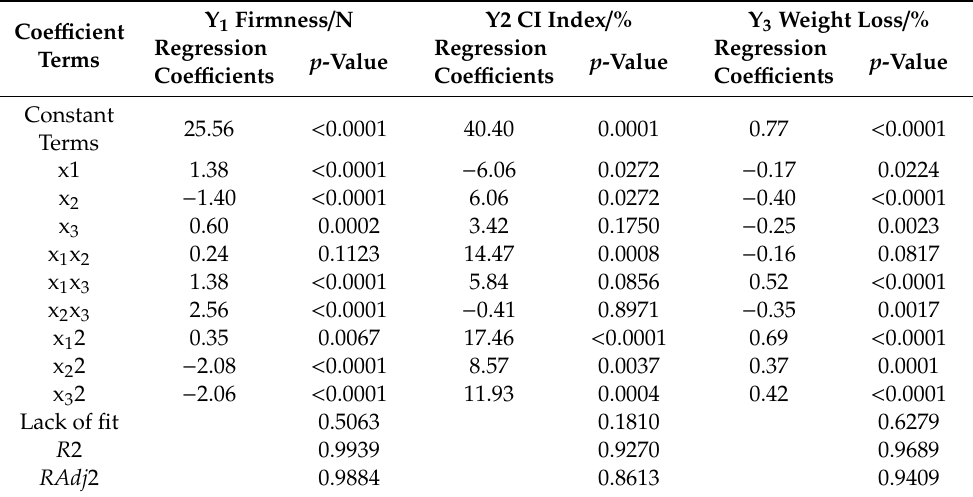
Table 4. ANOVA of each factor for the response surface quadratic